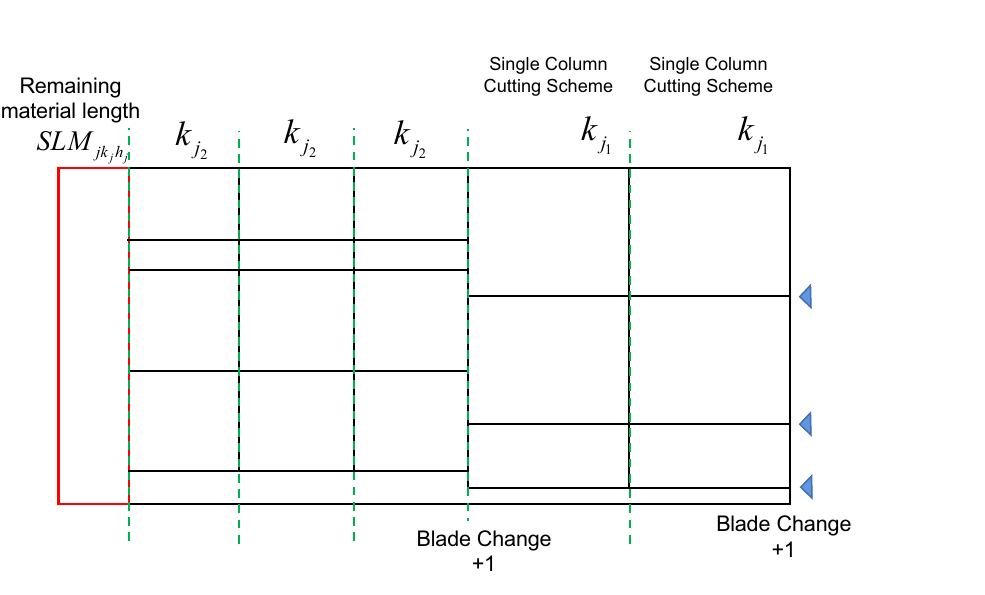
Figure 9. Schematic diagram of whole sheet cutting